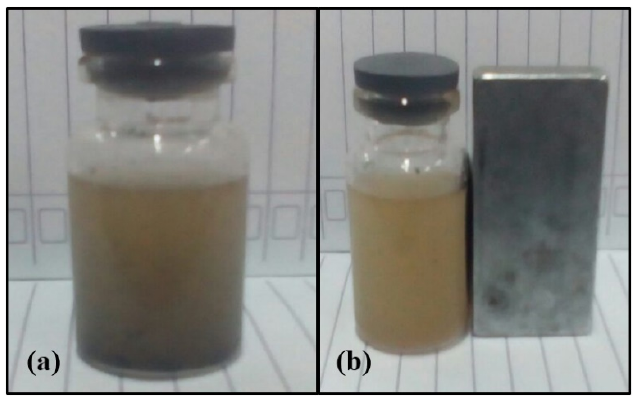
Figure 6. The obtained biodiesel produced from palm oil off-grade: ( a ) still contained the Fe 3 O 4 /CaO catalyst; ( b ) after being separated from the Fe 3 O 4 /CaO catalyst.